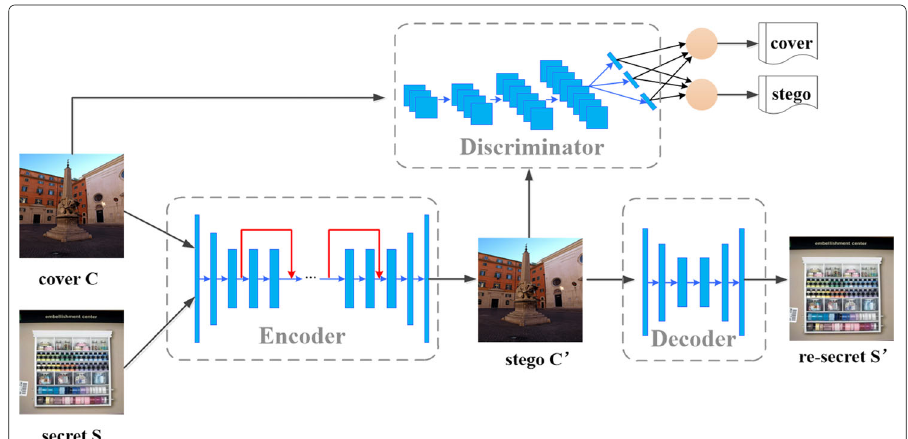
Fig. 1 The architecture of HIGAN. The whole steganography model is composed of sub-networks: encoder, decoder, and discriminator. Encoder could hide a secret color image into a cover color image with the same size. The steganographic images generated by encoder are used as the input of the decoder, and then, the secret images are extracted by decoder. Discriminator takes the cover images and steganographic images as input to distinguish whether the input images contain secret